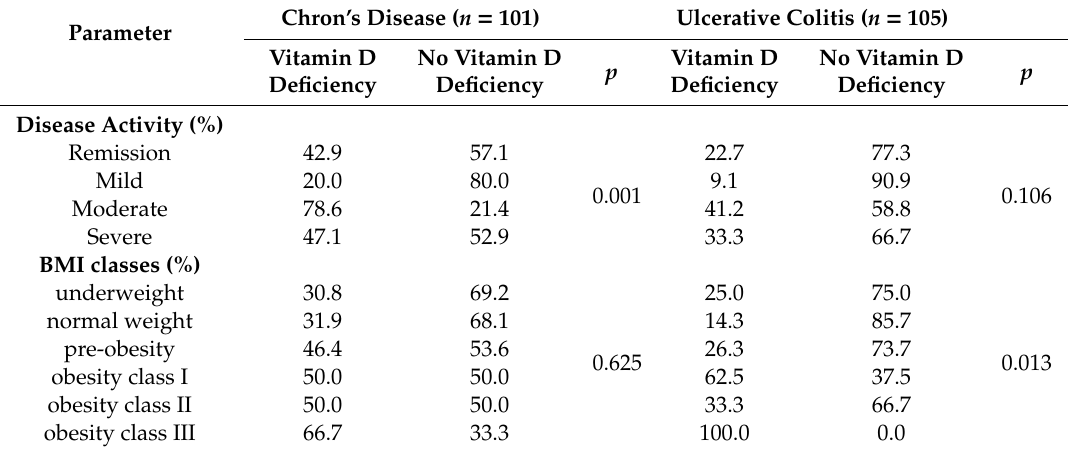
Table 4. Association between disease activity, BMI and Vitamin D deficiency.